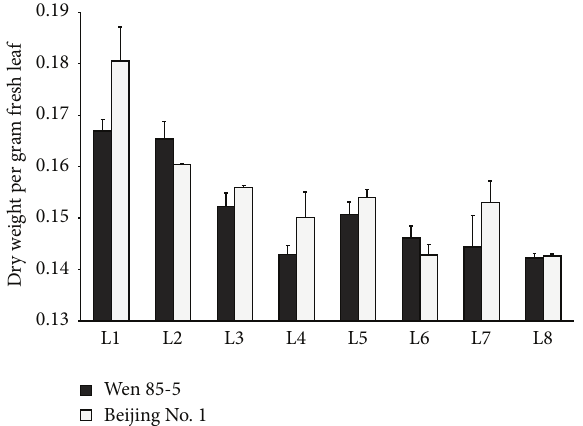
Figure 4: Dry weight of R. glutinosa L1–L8 leaves.